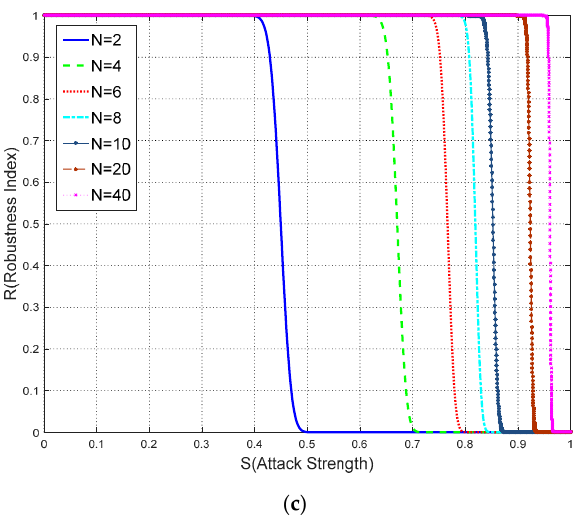
Figure 17. The relationship between robustness and watermark repeat times: ( a ) L = 100; ( b ) L = 200; ( c ) L = 300.